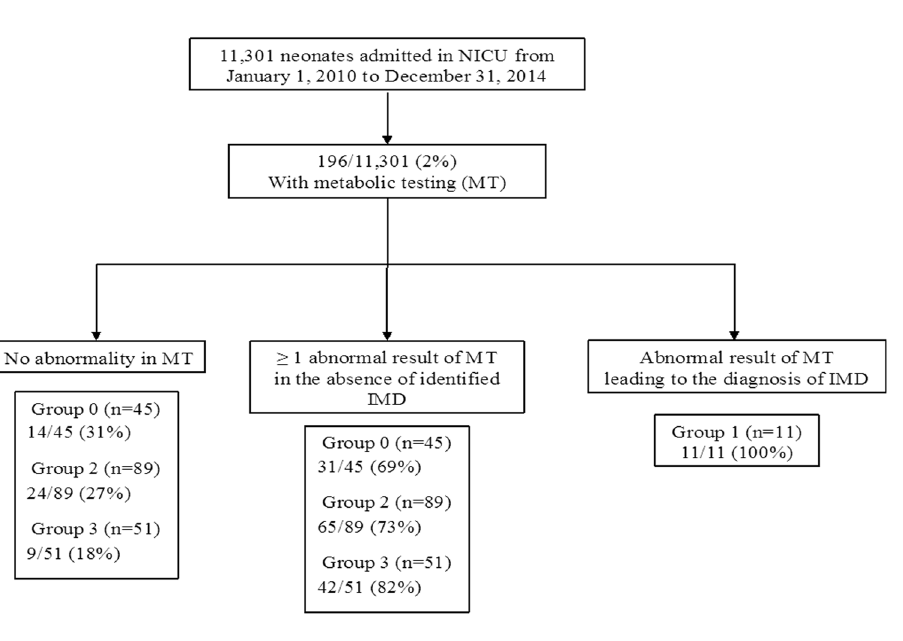
Figure 1. Flow chart of the study.